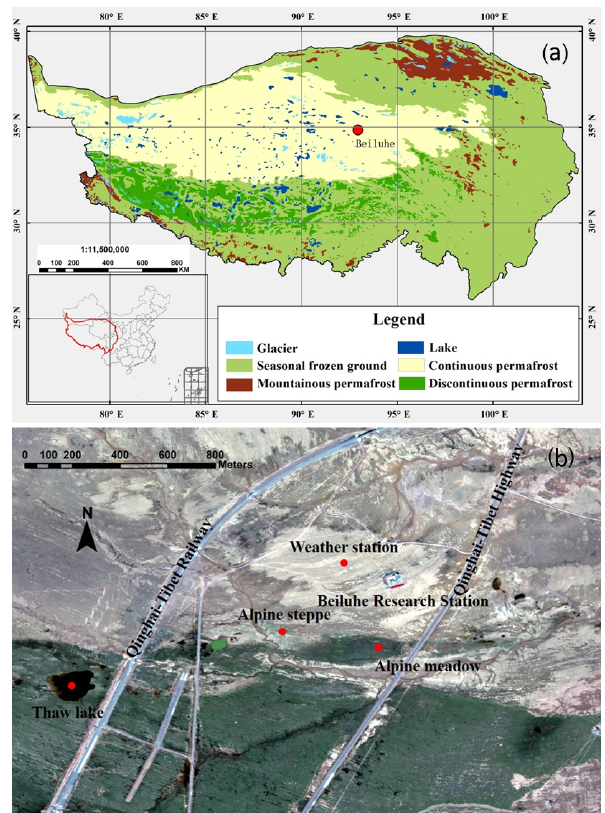
Figure 1. Locations of (a) Beiluhe permafrost station on the Qinghai–Tibetan Plateau, and (b) the weather station and the sur- rounding environment (map data: Google,